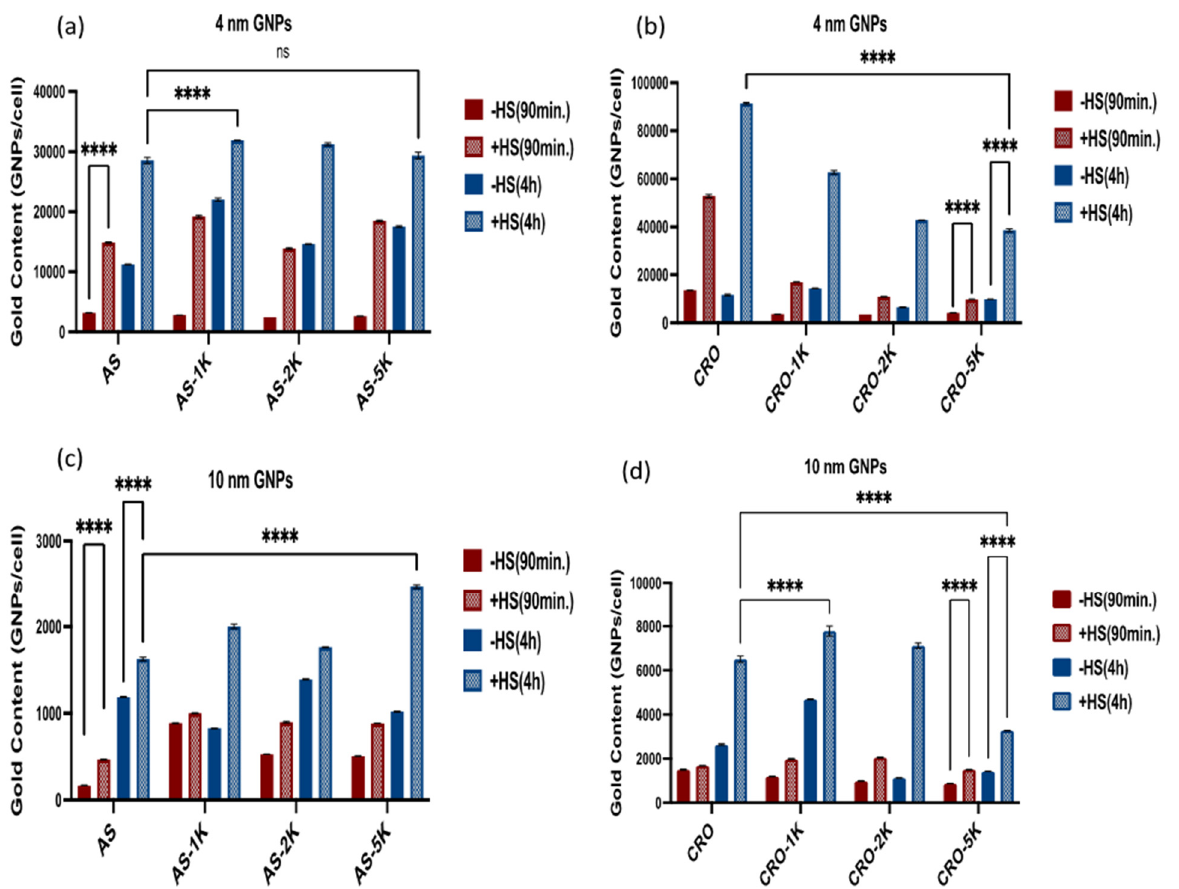
Figure 5. Cellular uptake of the GNP MRI contrast agents by RAW 264.7 cells at 90 min and 4 h, with 10% human serum-contained and human serum-free culture media. ( a ) The uptake of 4 nm GNP MRI contrast agents conjugated with AS1411. ( b ) The uptake of 4 nm GNP MRI contrast agents conjugated with CRO. ( c ) The uptake of 10 nm GNP MRI contrast agents conjugated with AS1411. ( d ) The uptake of 10 nm GNP MRI contrast agents conjugated with CRO. Each data point represents the mean ± standard deviation (SD) of triplicate experiments. **** denotes p < 0.0001 and ns denotes non-significance.